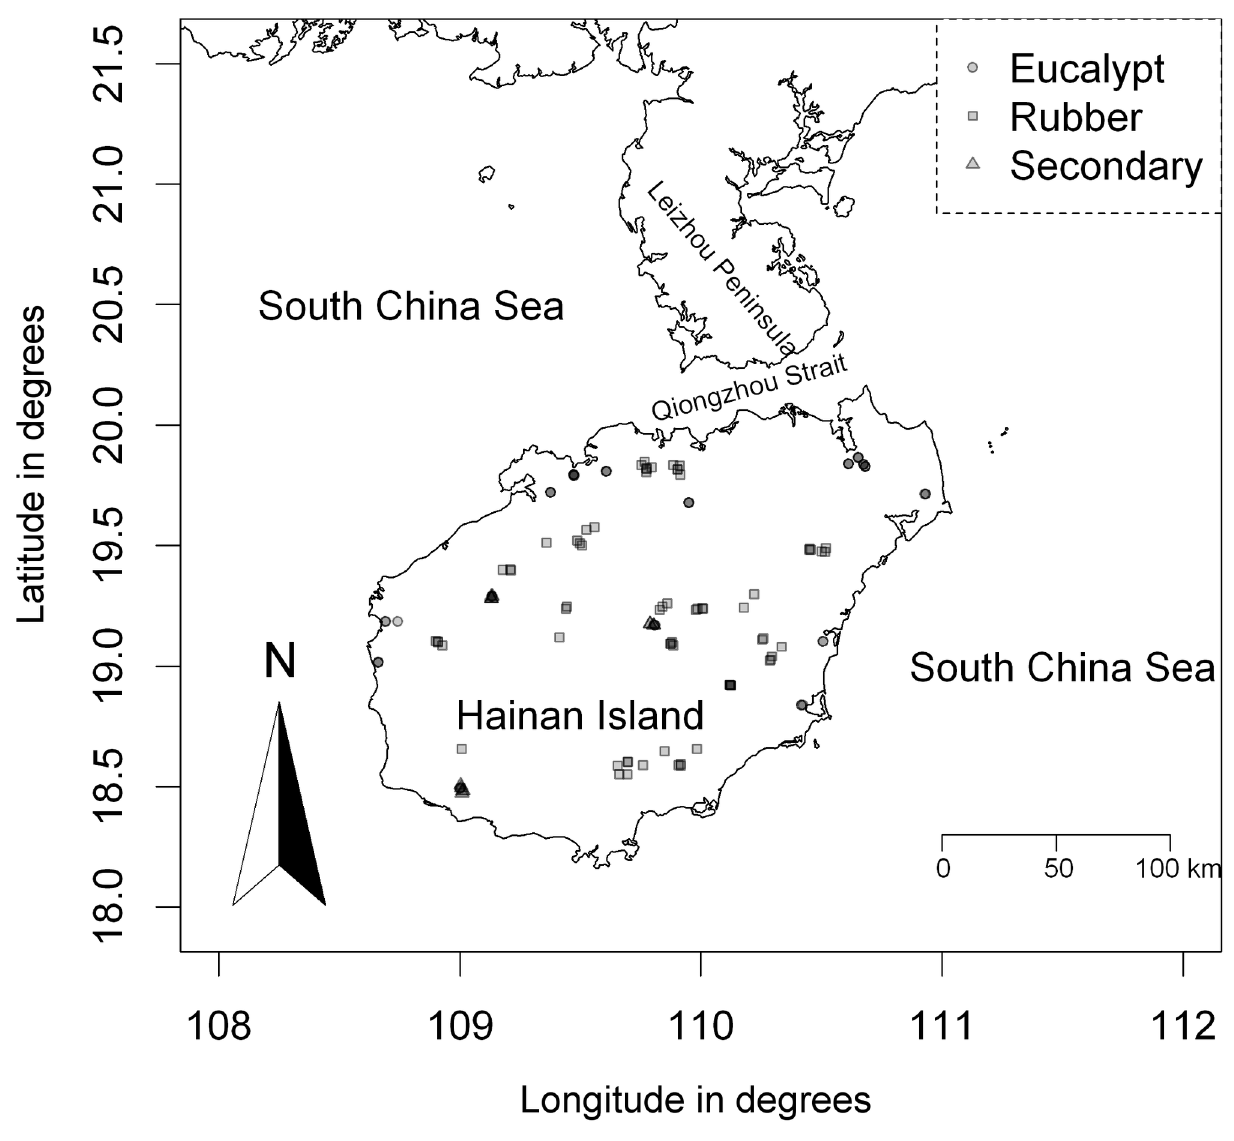
Figure 1. Distribution map of the 134 plots. Abbreviations: rubber (rubber plantation), eucalyptus (eucalyptus plantation), and secondary (secondary